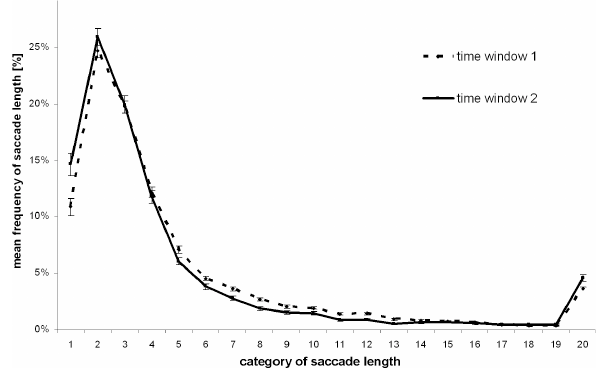
Figure 5. Mean percentage frequency of saccades on web pages depending on saccade length. Saccades were assigned to one of twenty categories (category 1: saccade length ≤ 1° visual angle; category 2: saccade length >1° and ≤ 2°; …; category 20: saccade length >19°). Vertical lines indicate standard error of the